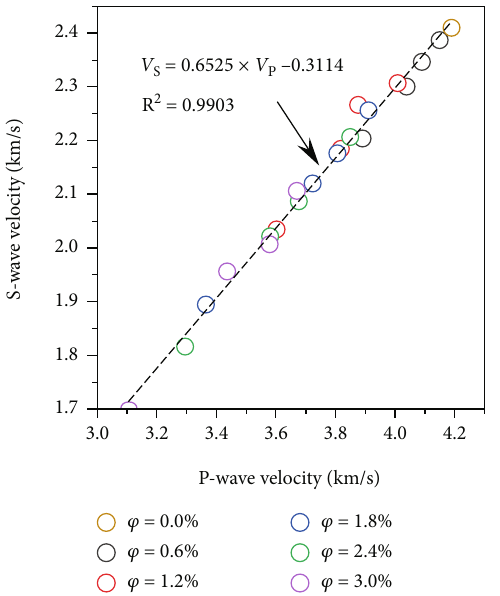
Figure 7: The linear relations of V four model